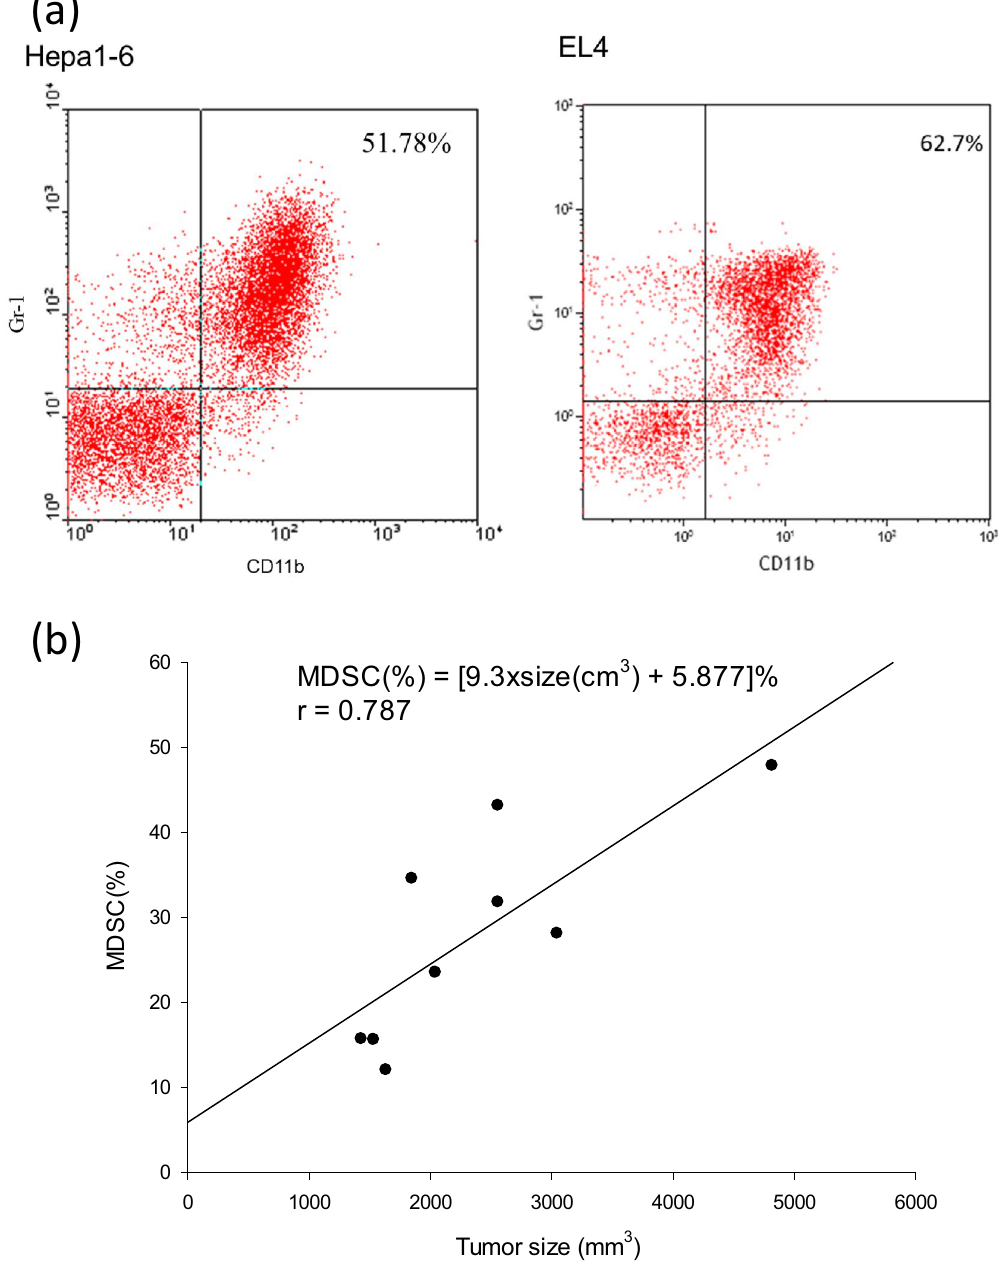
Figure 1. MDSCs in tumor-bearing mice. ( a ) Representative MDSCs expressing Gr-1 and CD11b in the spleen cells from B10 mice bearing Hepa1-6 tumors and B6 mice bearing EL4 tumors. ( b ) The frequency of MDSCs